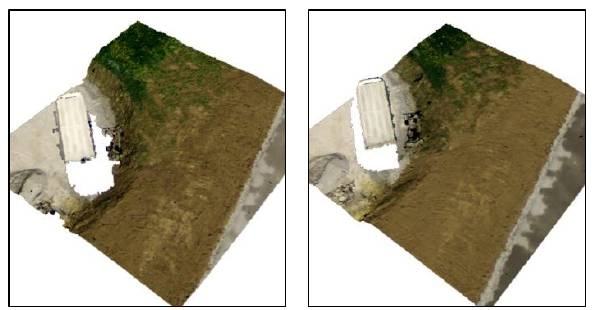
Figure 1. Corresponding info clouds from overlapping ADS strips, based on image patches of 512 x 512